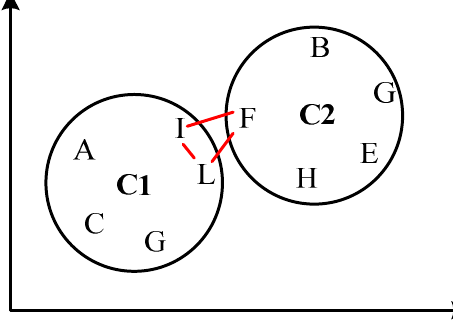
Figure 1. Similarity between border elements of different groups.